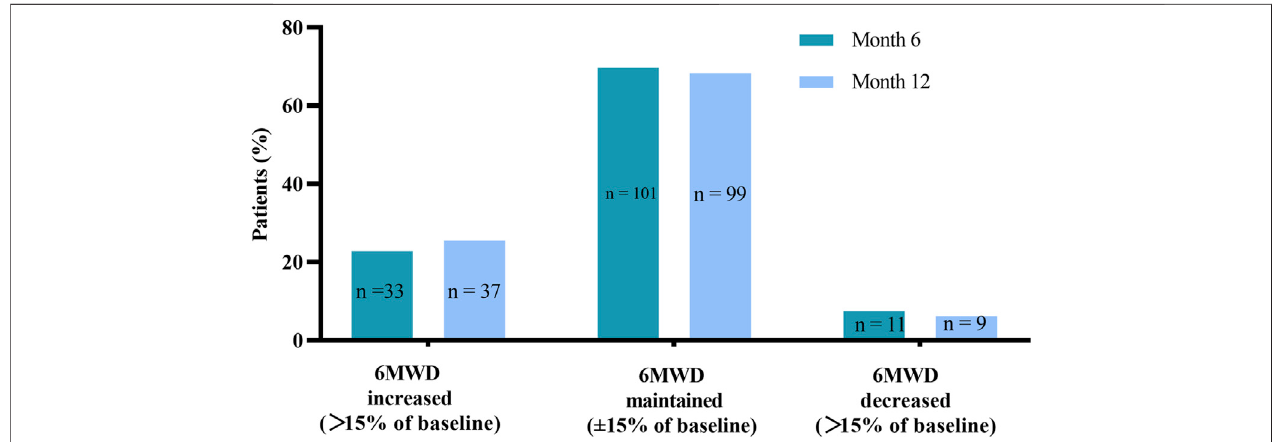
Frontiers in Pharmacology |